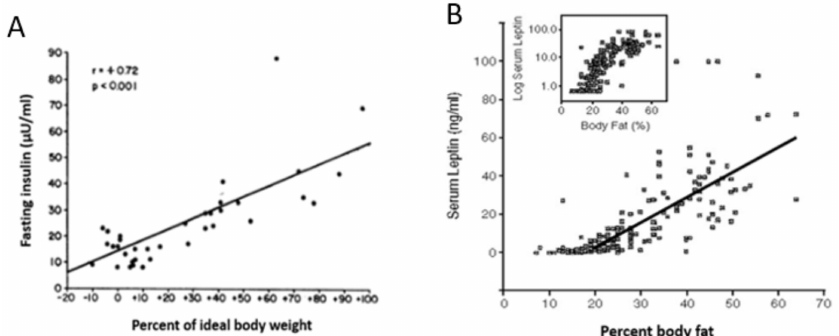
Figure 4. The positive relationship between human ideal body weight (left) or body fat level and basal concentrations of insulin ( A ) and leptin ( B ). Data were modified from Bagdade, Bierman, Porte Jr. The significance of basal insulin levels in the evaluation of the insulin response to glucose in diabetic and nondiabetic subjects. J Clin Invest. 1967, 46(10), 1549–1557 [32] and Considine, Sinha, Heiman, Kriauciunas, Stephens, Nyce, Ohannesian, Marco, McKee, Bauer et al. Serum immunoreactive-leptin concentrations in normal-weight and obese humans. N. Engl. J. Med. 1996,